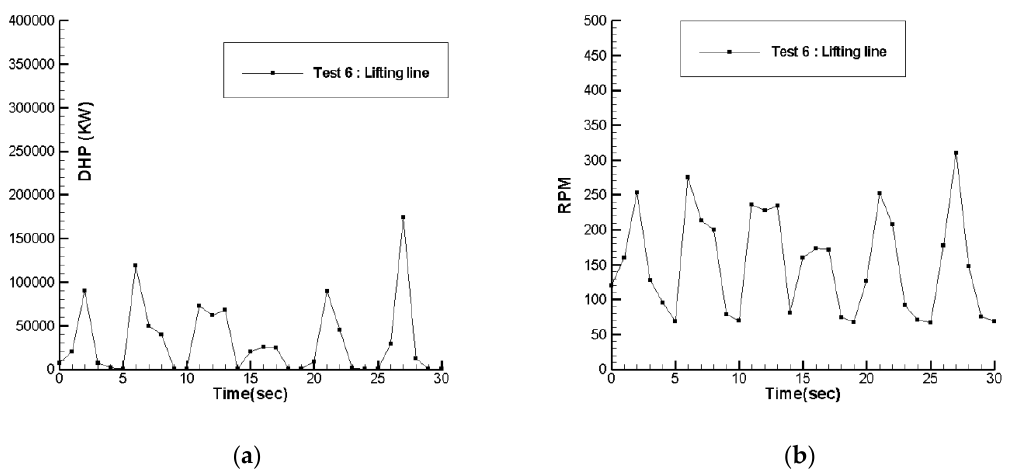
Figure 32. Time history of the required DHP ( a ) and RPM ( b ), numerical experiment #5.